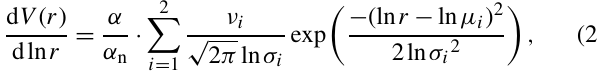
532nm wavelength, assuming dry